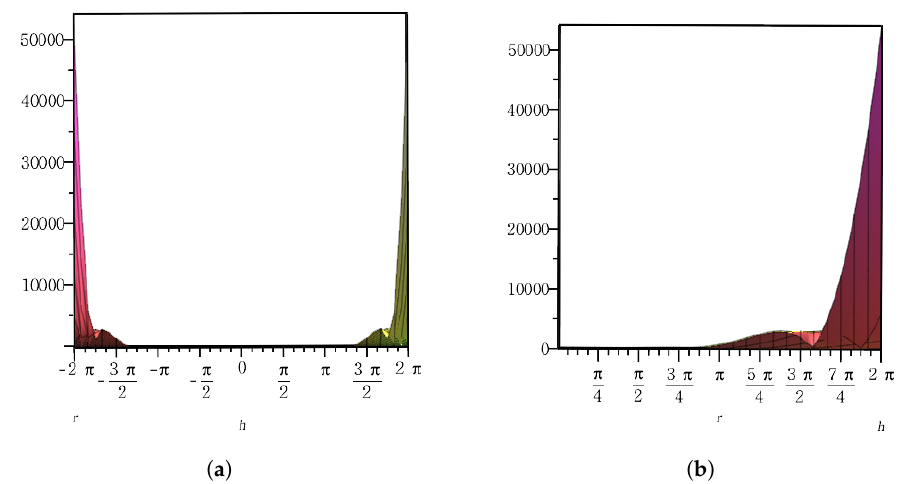
Figure 6. ( a ) Side view of Figure 5a observed in the direction perpendicular to h . ( b ) Side view of Figure 5a observed in the direction perpendicular to r